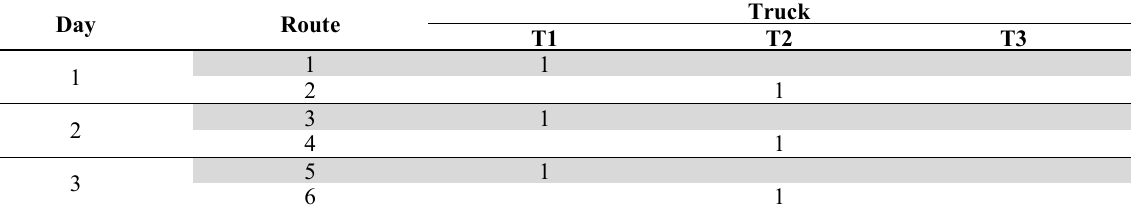
Solution of Instance II: reinforcement